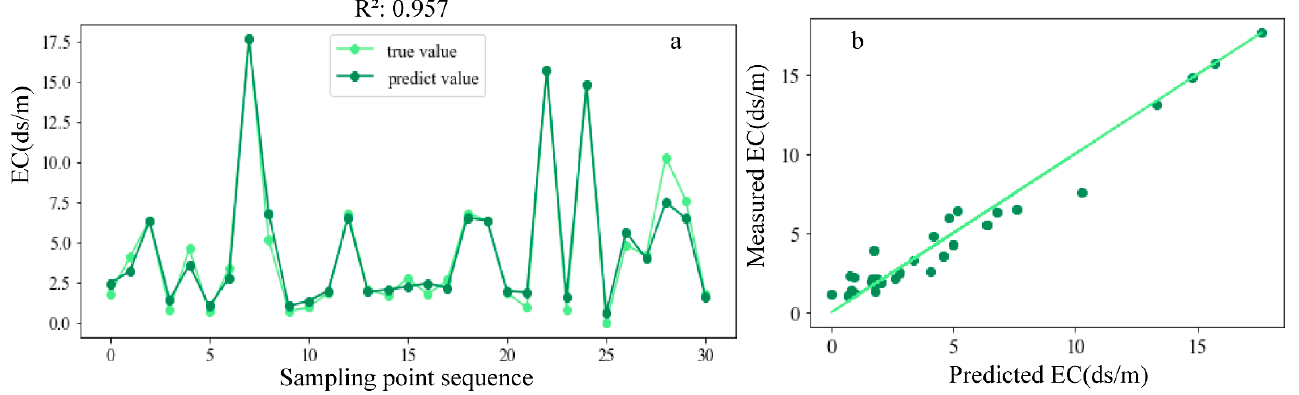
Figure 10. Fitting effect graph of ERT for EC ( a ) and model using validation correlation diagram of ERT for EC ( b ) in July 2018.